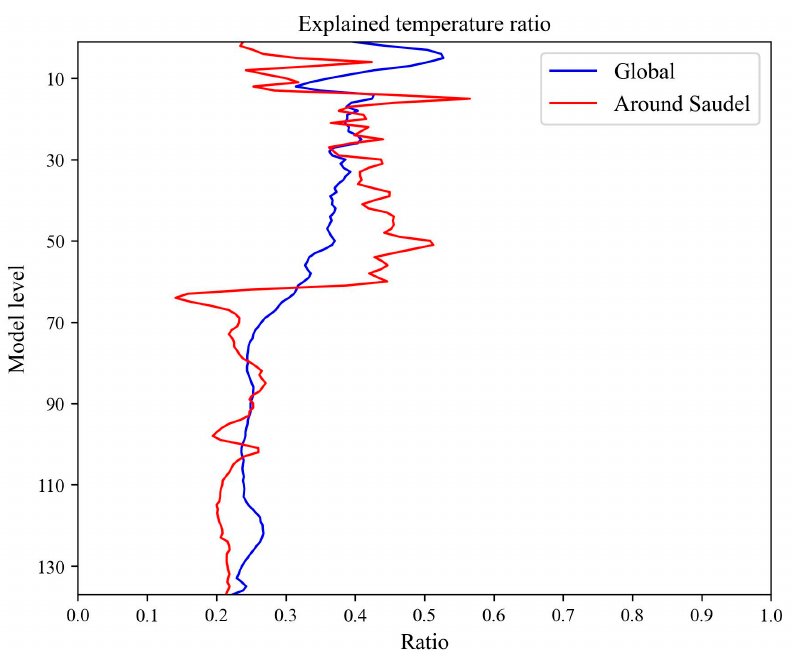
Figure 3. Vertical profiles of the ratio of the total temperature variance that is explained by vorticity for the global average (blue line) and around Saudel (red line) at 1200 UTC 19 October 2020.